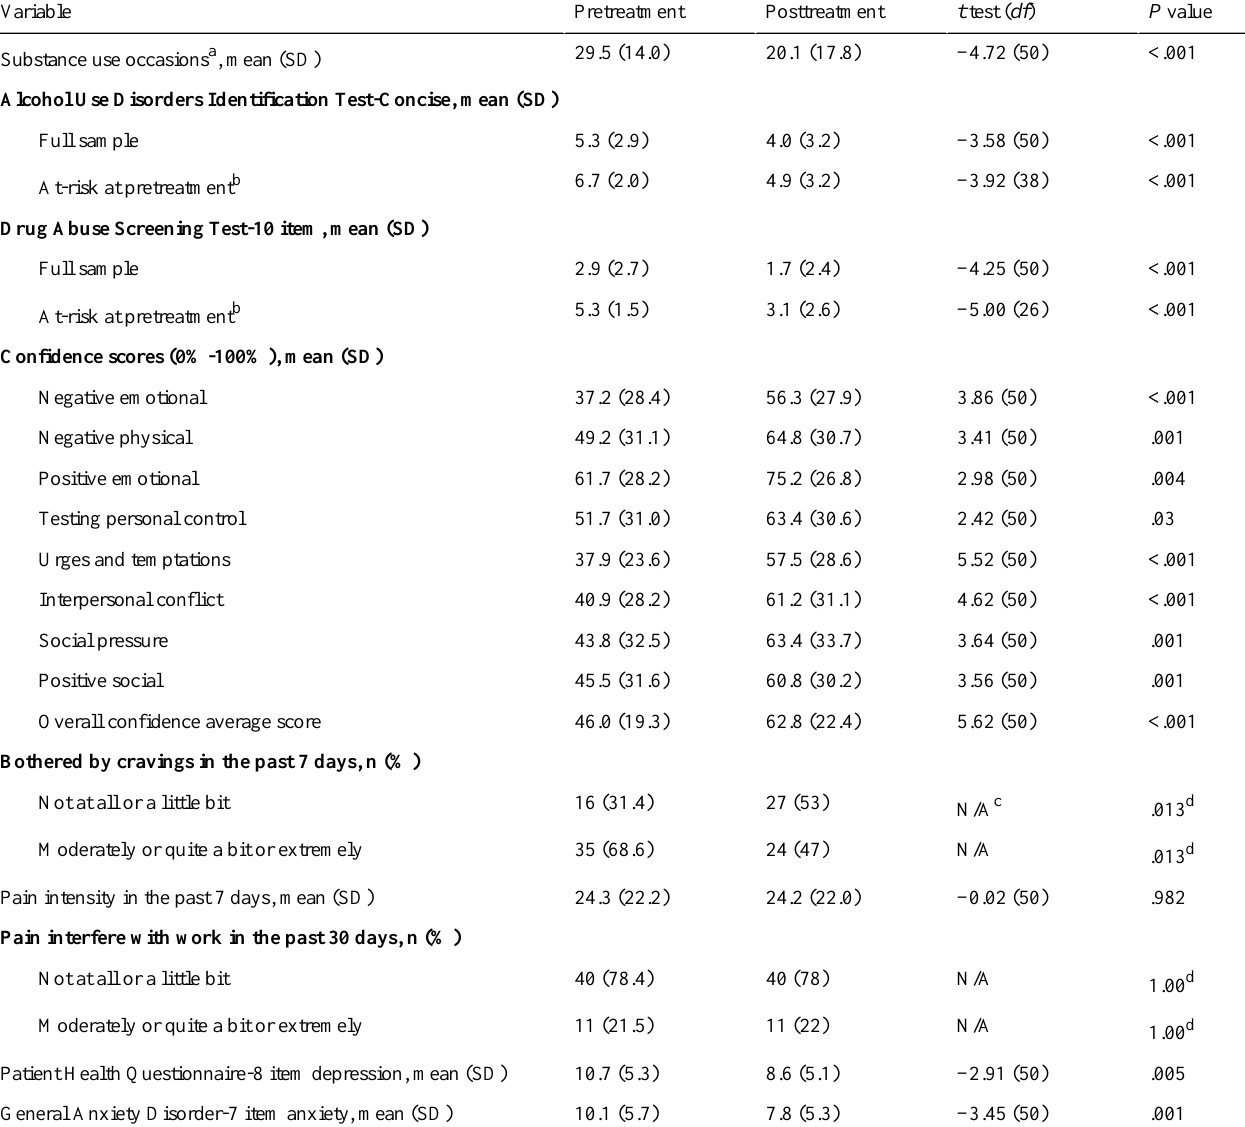
Table 3. Pre- to posttreatment changes in substance use and mental health measures (n=51).